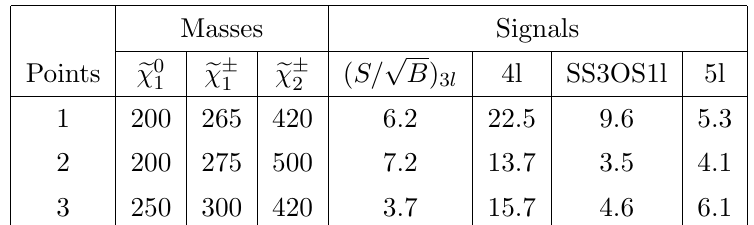
Table 21 . Number of events surviving all cuts for all types of signals for an integrated luminosity of 100 fb (cid:0) 1 in the moderately compressed model. Masses are given in GeV.